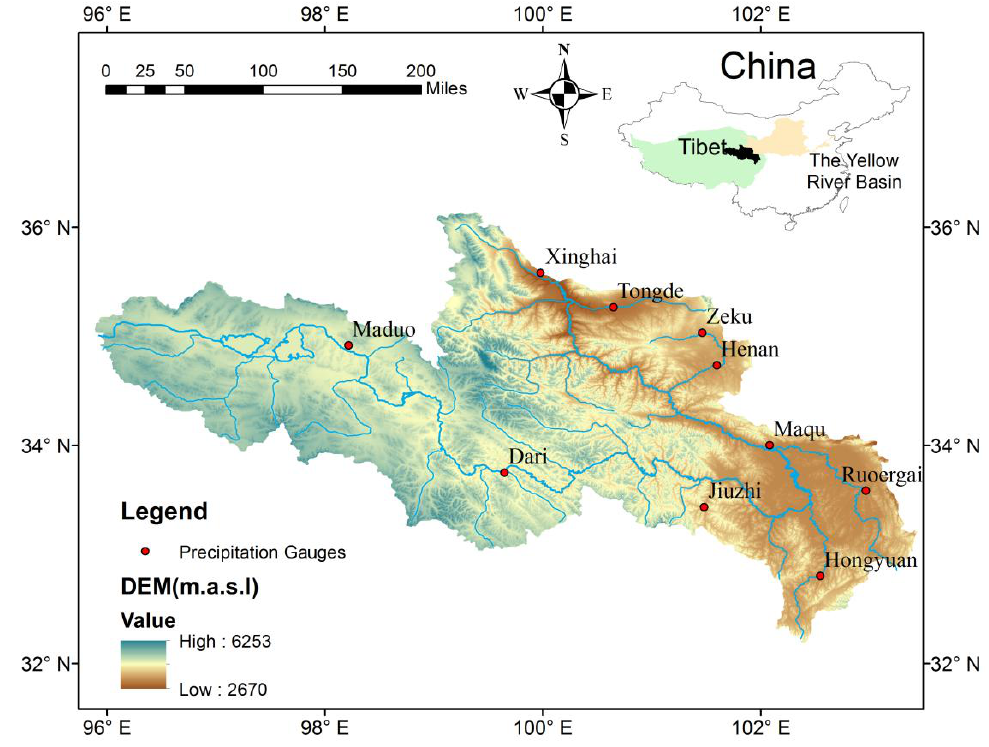
Figure 1. Map of study area with precipitation gauges.